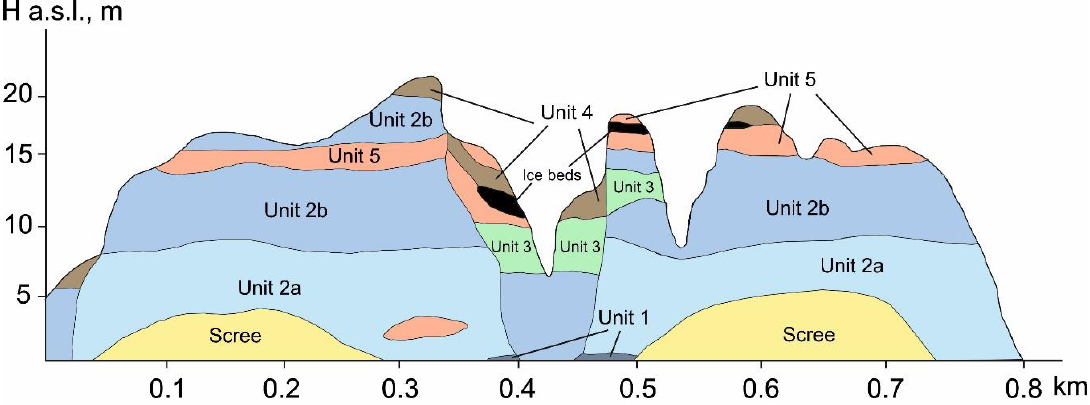
Figure 1. Diversity of the sediments comprising the geological section of the Lorino coastal bluff [36,37] . A description of sedimentary units is given in the text.